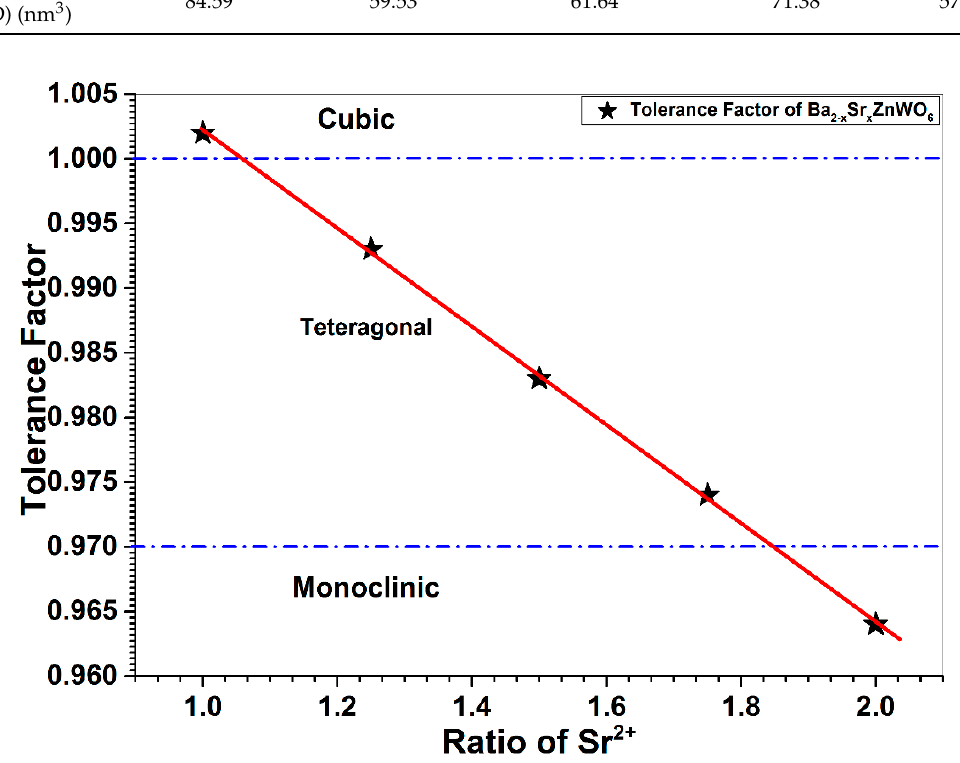
Figure 2. Rietveld refined XRD pattern of the Ba 0.75 Sr 1.25 ZnWO 6 sample.